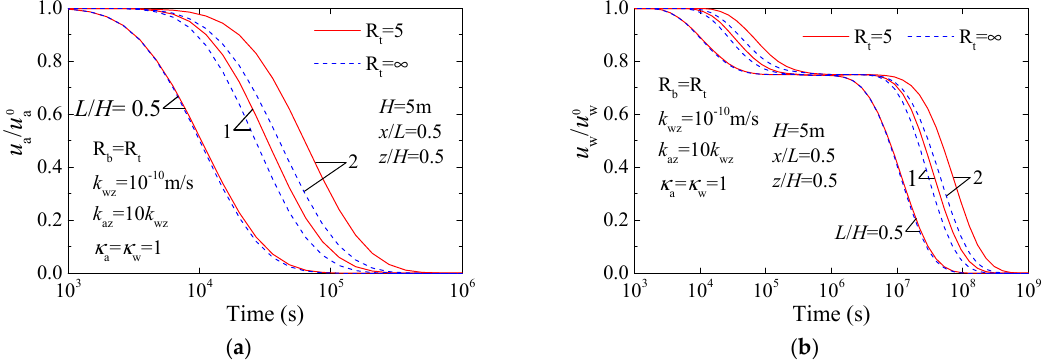
Figure 13. Variations of excess pore-pressures under vertical impeded drainage boundary with different spacing-depth ratios: ( a ) air phase and ( b ) water phase.